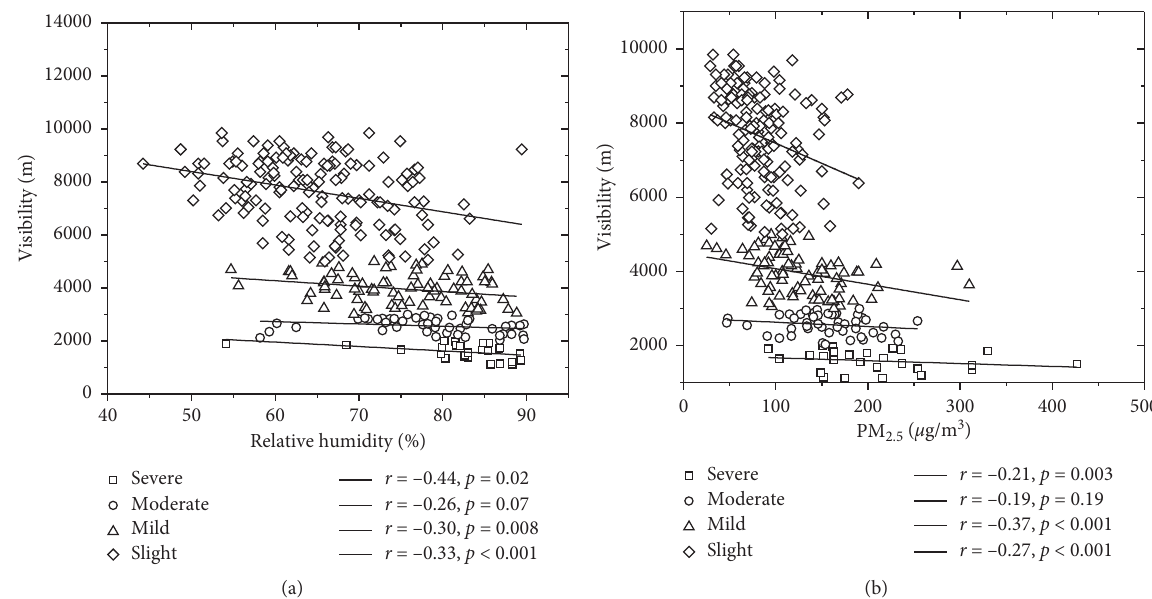
Figure 5: Relation between visibility and relative humidity (a) and PM